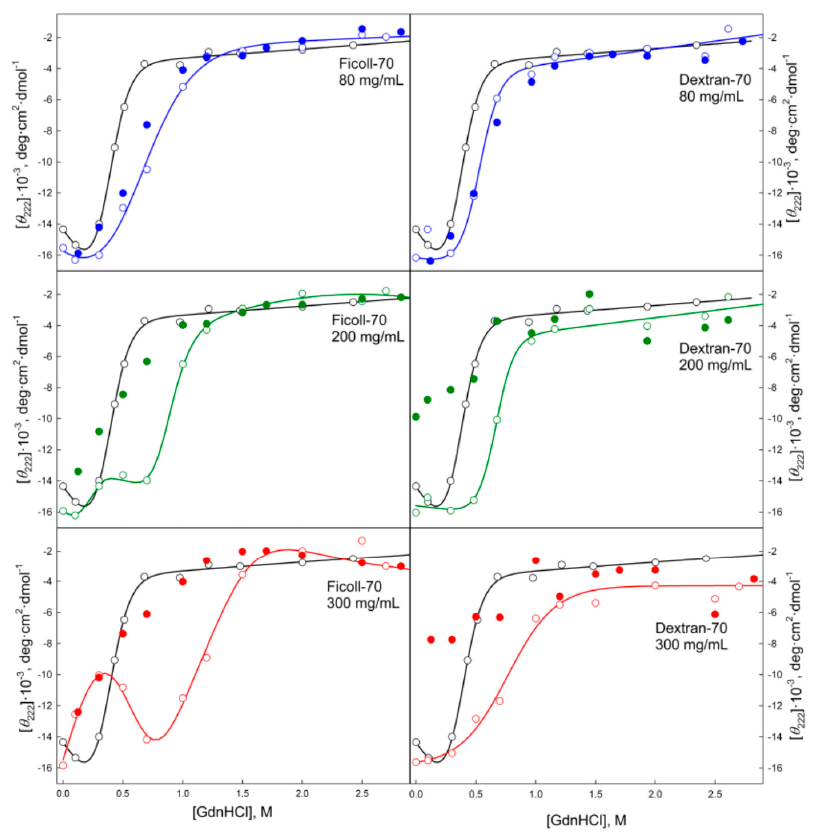
Figure 11. Unfolding/refolding transitions of GGBP in the presence of different concentrations of Ficoll-70 and Dextran-70 recorded by the dependence of the molar ellipticity at 222 nm on GdnHCl concentration. Other designations as in Figure 4.